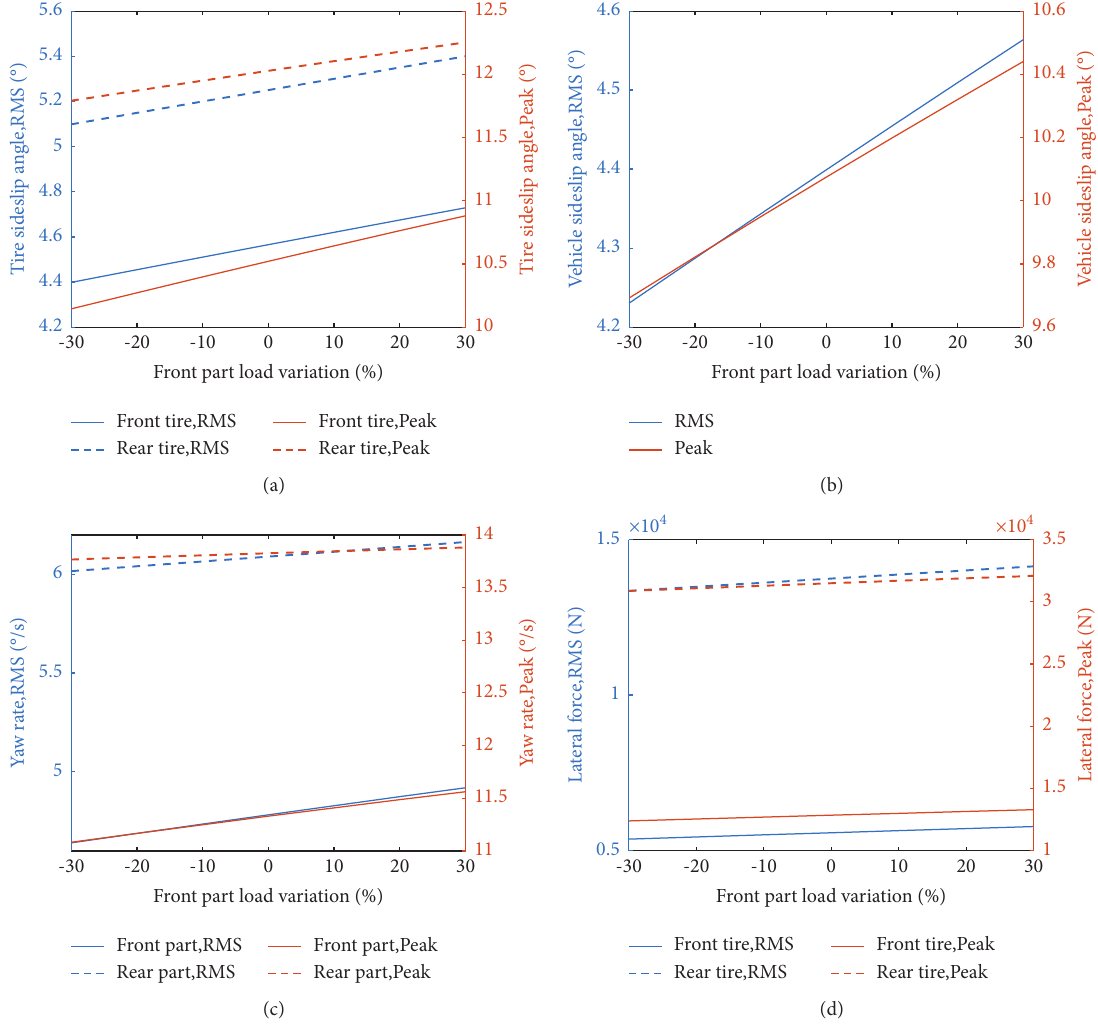
Figure 9: Vehicle performance of the front part load variation. (a) RMS and peak value of tire sideslip angle. (b) RMS and peak value of vehicle sideslip angle. (c) RMS and peak vehicle yaw rate. (d) RMS and peak value of lateral